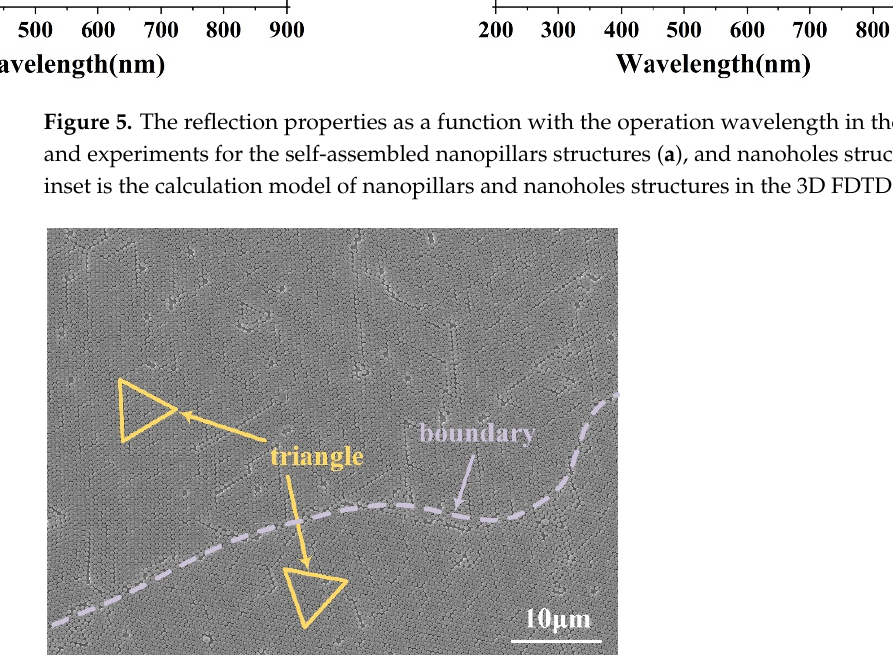
Figure 6. SEM image of the PS nanosphere surface. The red dashed line is the boundary of PS nanospheres region, and the triangle illuminates the arrangement of adjacent nanospheres.